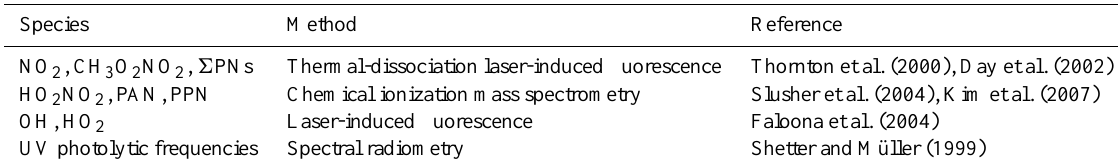
Table 3. Measurements used in this analysis and calculations of the lifetimes in Fig. 1.